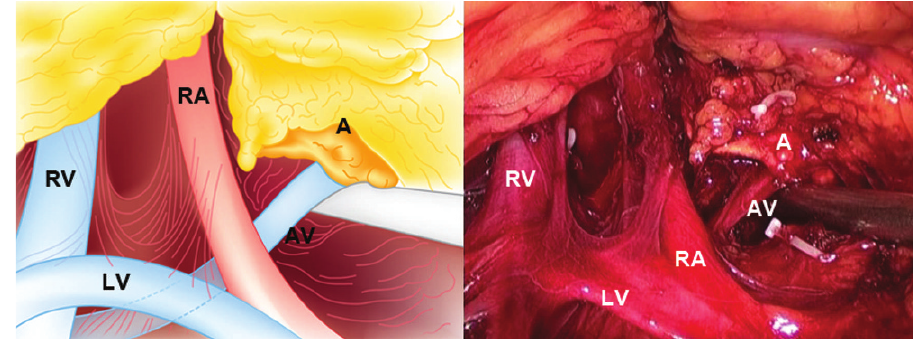
Figure 4 - Left-side retroperitoneoscopic view. A: adrenal. AV: adrenal vein. LV: lumbar vein. RA: renal artery. RV: renal vein. Note the laparoscopic clips for the inferior and medial adrenal